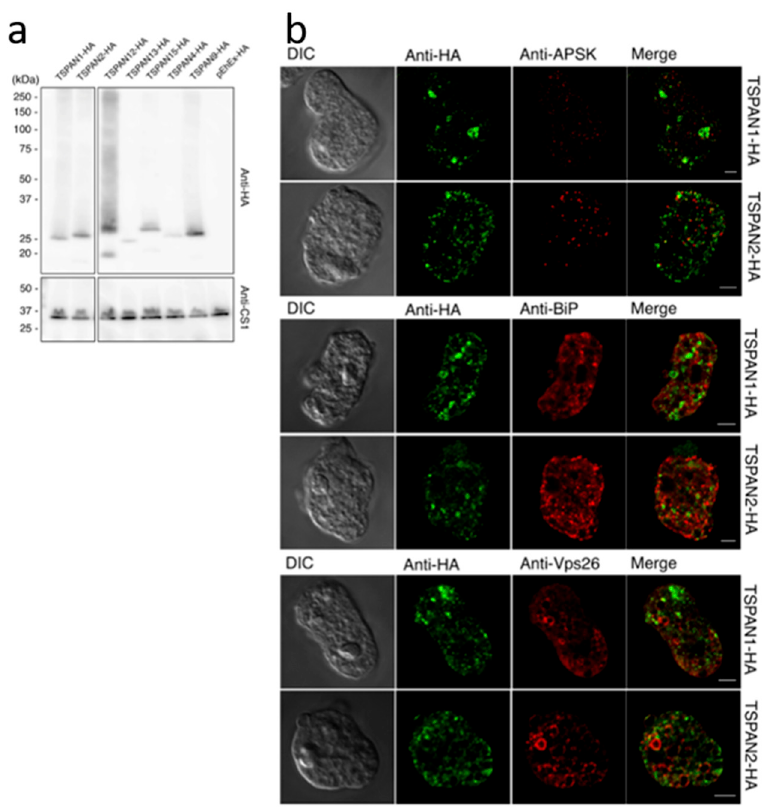
Figure 6. Expression of TSPAN1-HA and TSPAN2-HA in E. histolytica. ( a ) Immunoblot analysis of total cell lysate from representative tetraspanin-expressing and pEhEx-HA control strains respectively. Approximately 20 µ g of protein was separated by SDS-PAGE and transferred to PVDF membranes. The membranes were reacted with anti-HA antibody (top panel) and anti-CS1 antiserum (bottom panel, loading control) respectively. ( b ) Immunofluorescence assay micrographs of TSPAN1-HA and TSPAN2-HA double-stained with mouse anti-HA antibody (green) and rabbit anti-APSK (red, top panel), anti-BiP (red, middle panel), and anti-Vps26 (red, bottom panel) antisera respectively. Scale bar, 5 µ m.